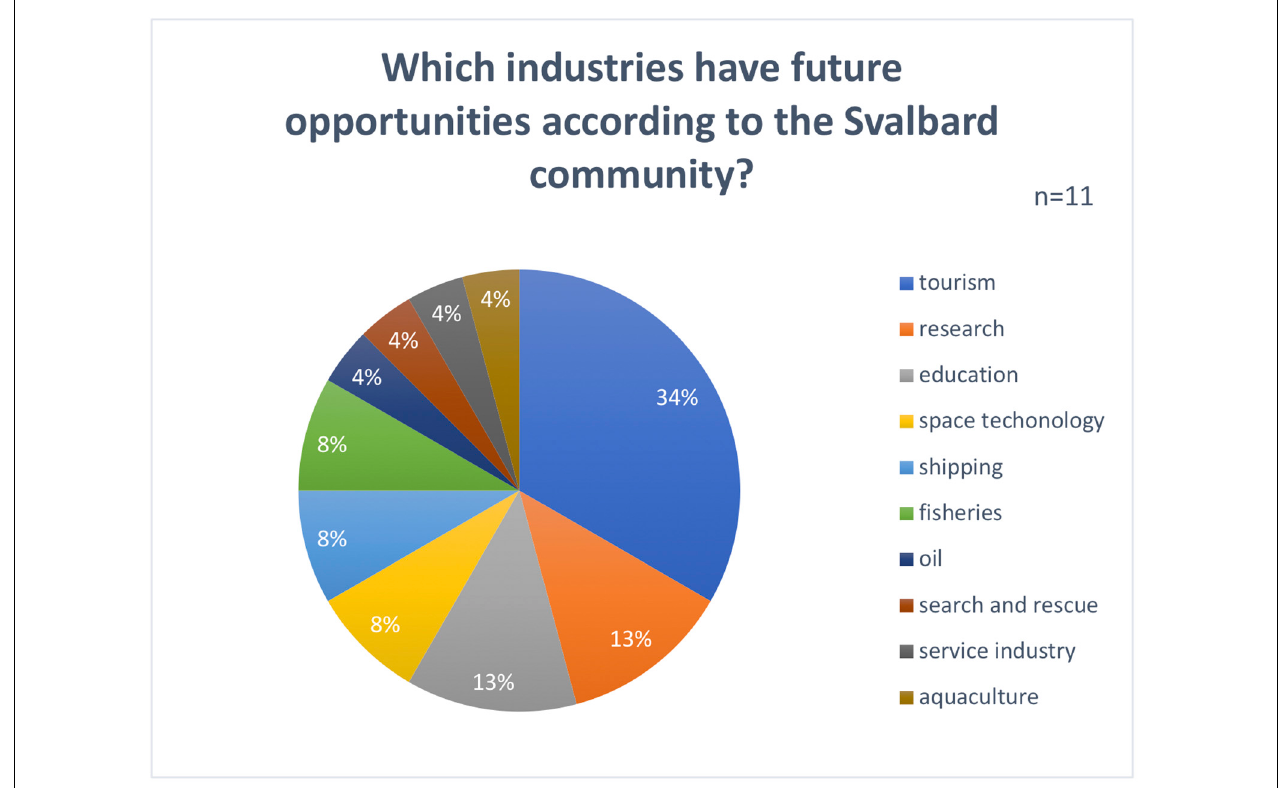
FIGURE 4 | Question posed to interviewees in Longyearbyen, Svalbard. Tourism was what was considered as having most potential, and fisheries only was discussed in 8% of the cases.